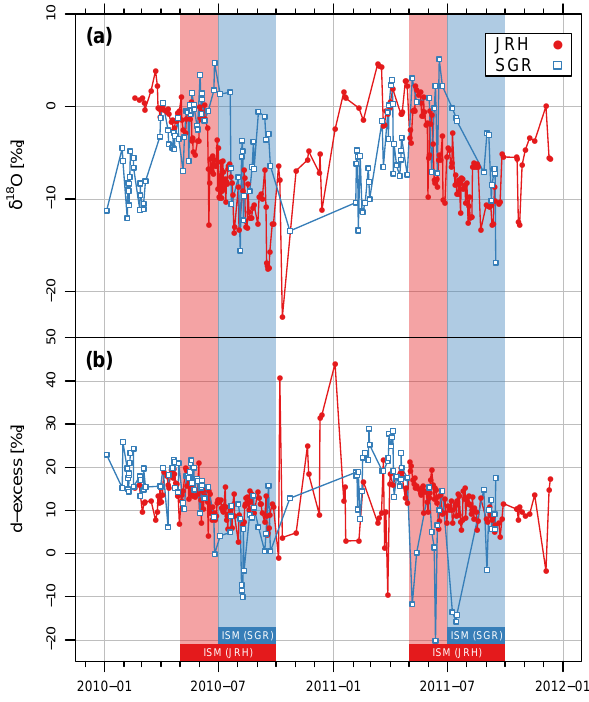
Figure 4. δ 2 H– δ 18 O relationship for daily isotope data available for Jorhat (JRH) and Srinagar (SGR) stations. Local meteoric water lines were calculated separately for Indian summer monsoon (ISM) and western disturbances (WD)